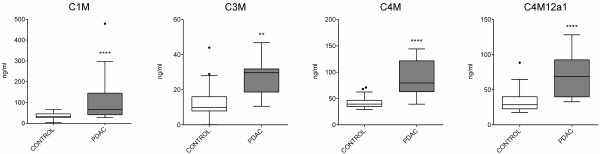
Levels of MMP-generated fragments of type I, III and IV collagen are significantly elevated in serum from PC patients as compared to controls. Biomarkers of MMP-2/-9/-13 mediated degradation of collagen type I (C1M), MMP-9 mediated collagen type III (C3M) and MMP-9 mediated (C4M) and MMP-12 mediated (C4M12a1) degradation of collagen type IV in serum from patients with pancreatic ductal adenocarcinomas (PDAC) (n = 15) and healthy controls (n = 33). Groups were compared using an unpaired t-test on Log transformed data. Results are presented as Tukey box plots, boundaries of each box indicate 25th and 75th percentiles, the line within the box marks the median and whiskers indicate maximum and minimum. Significance levels: **p < 0.01, ****p < 0.0001.